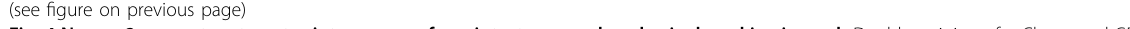
S100 β (AAV-FLEX-NLSGFP: 93.94 ± 2.61%, n = 4 mice, Supplementary Fig. S3a, a ′ ; AAV-FLEX-Neurog2/GFP: 94.56 ± 4.11%, n = 3 mice; Supplementary Fig. S3b, b ′ ) was found at 3 DPI, but GFP barely colocalized with NeuN (AAV-FLEX-NLSGFP: 4.43 ± 2.64%, n = 3 mice; Supplementary Fig. S3c, c ′ ; AAV-FLEX-Neurog2/GFP: 1.38 ± 2.03%, n = 3 mice Supplementary Fig. S3e, e ′ ) in both AAV-FLEX-NLSGFP- and AAV-FLEX-Neurog2/ GFP-infected mice. At 30 DPI, GFP + cells hardly expressed NeuN in the dorsal midbrain tissues infected with AAV-FLEX-NLSGFP (AAV-FLEX-NLSGFP: 3.80 ± 2.70%, n = 3 mice; Supplementary Fig. S3d, d ′ ). However, the majority of GFP + cells colabeled with NeuN in tissues infected with AAV-FLEX-Neurog2/GFP (AAV-FLEX- NLSGFP: 79.43 ± 12.79%, n = 3 mice; Supplementary Fig. S3f, f ′ ). Thus, the conditional expression of Neurog2 is also capable of converting astrocytes into neurons.